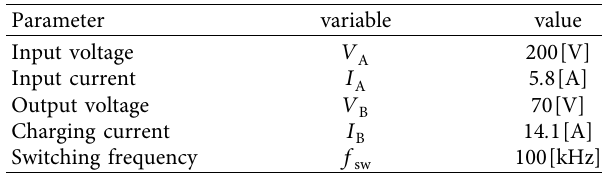
Table 4: Poles of reduced discrete system matrix A state variables i and i of transformer model in Z -domain. s h